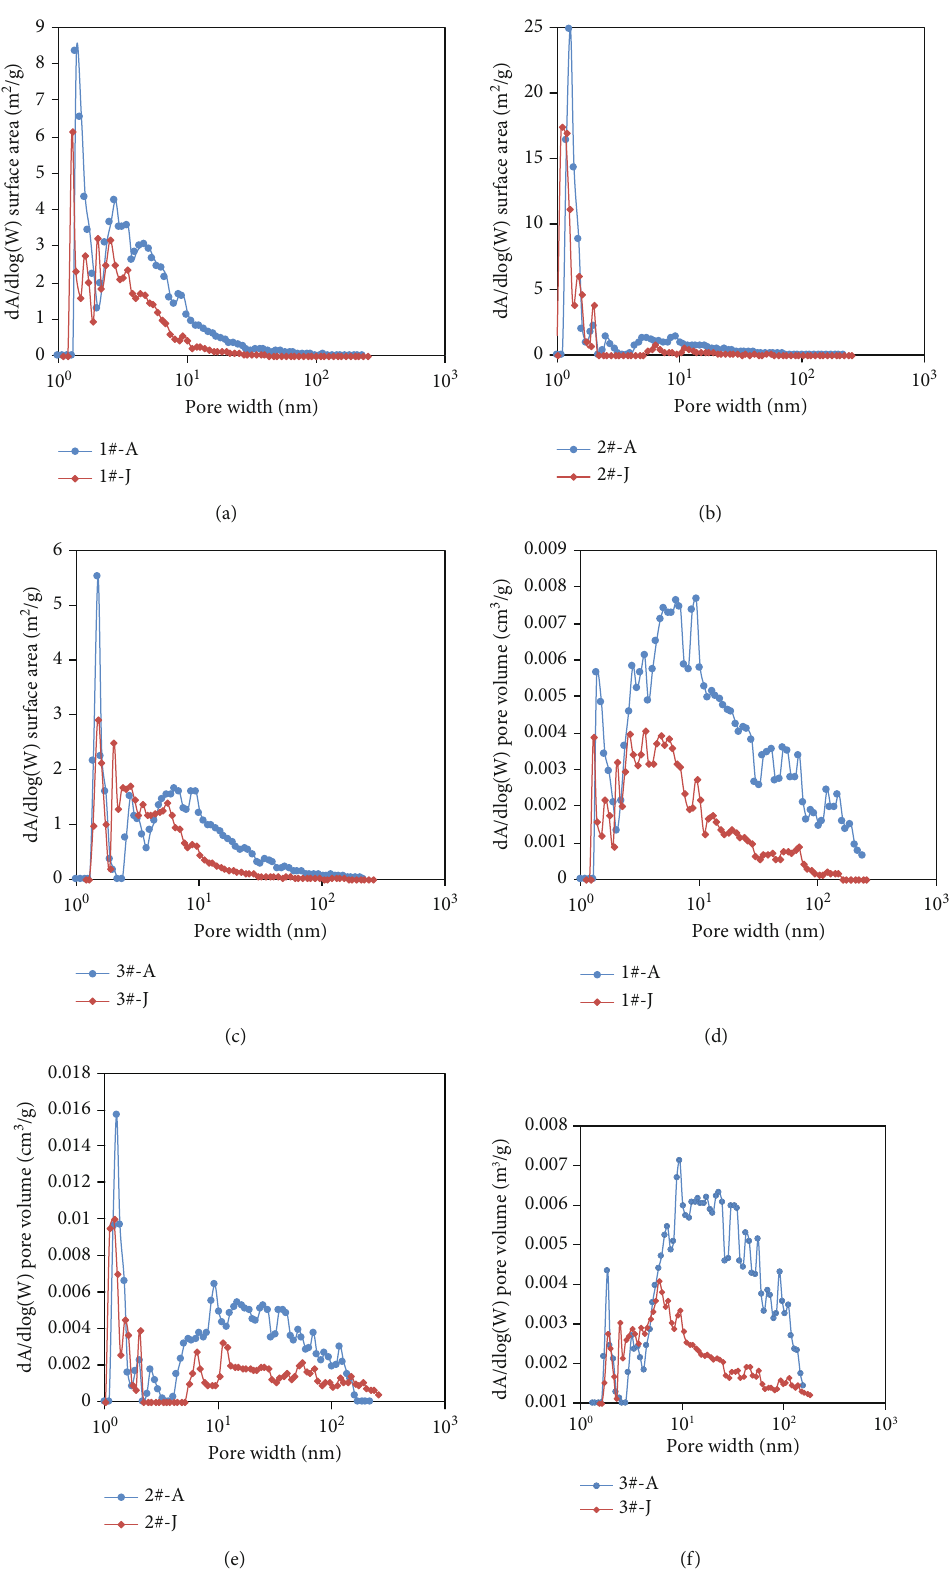
Figure 5: PSD is calculated according to the liquid N